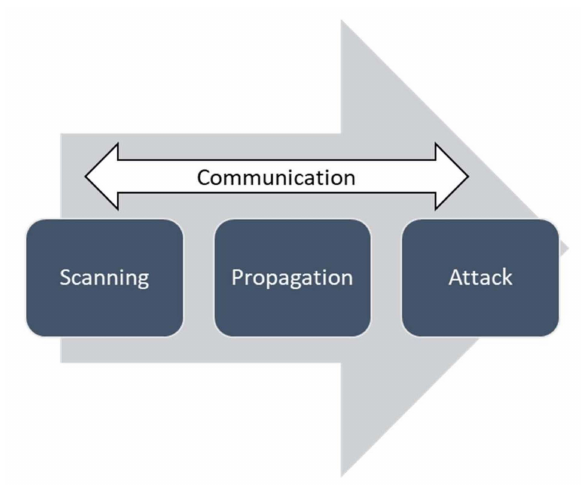
Figure 3. Phases of an IoT botnet’s life